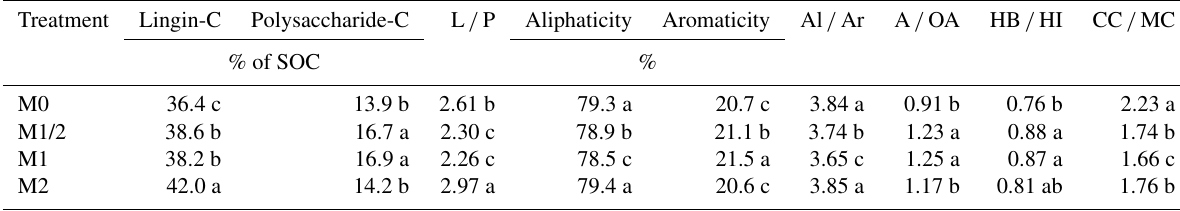
Table 6. CPMAS 13 C-NMR indices of SOM from surface soils in grassland soils with different mowing frequencies.